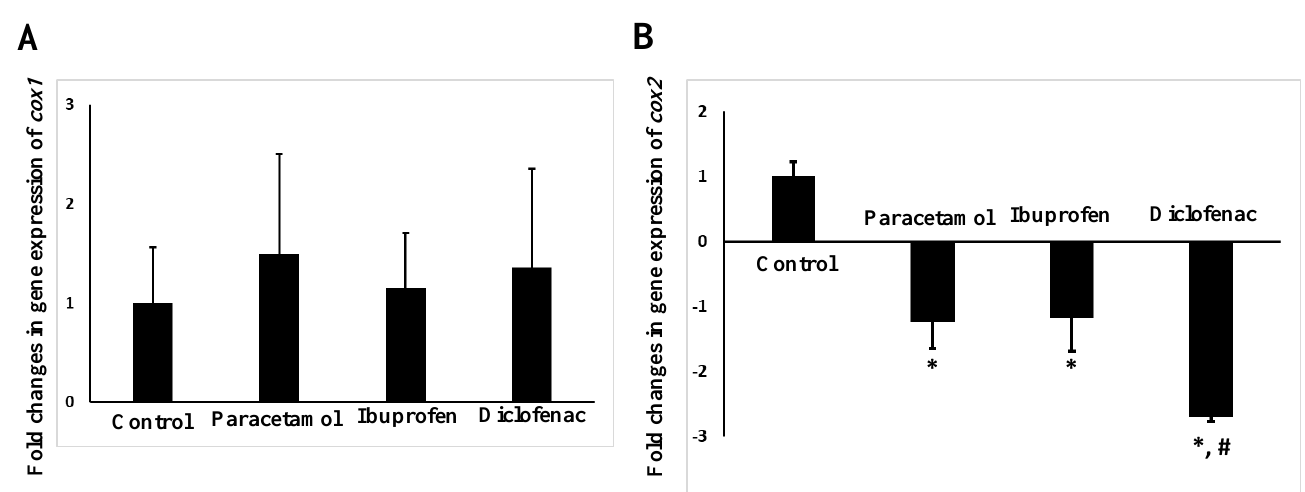
Figure 5. Expression of cox1 ( A ) and cox2 ( B ) genes in the lungs of NSAID- and paracetamol-treated mice. The target expression was quantified relative to the expression of Actin gene. Fold change is the ratio of mean expression of the NSAID- and paracetamol-treated to the control value. Negative values indicate a reduction in fold change. * indicates a statistical difference ( p < 0.05, one-way ANOVA test) in comparison with the control group, while # indicates a statistical difference in comparison of diclofenac with other analgesics.